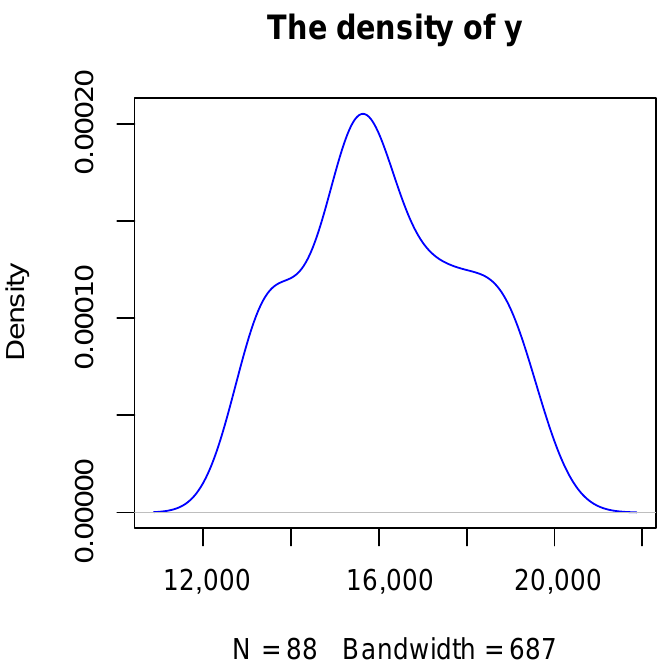
Figure 1. The density of the